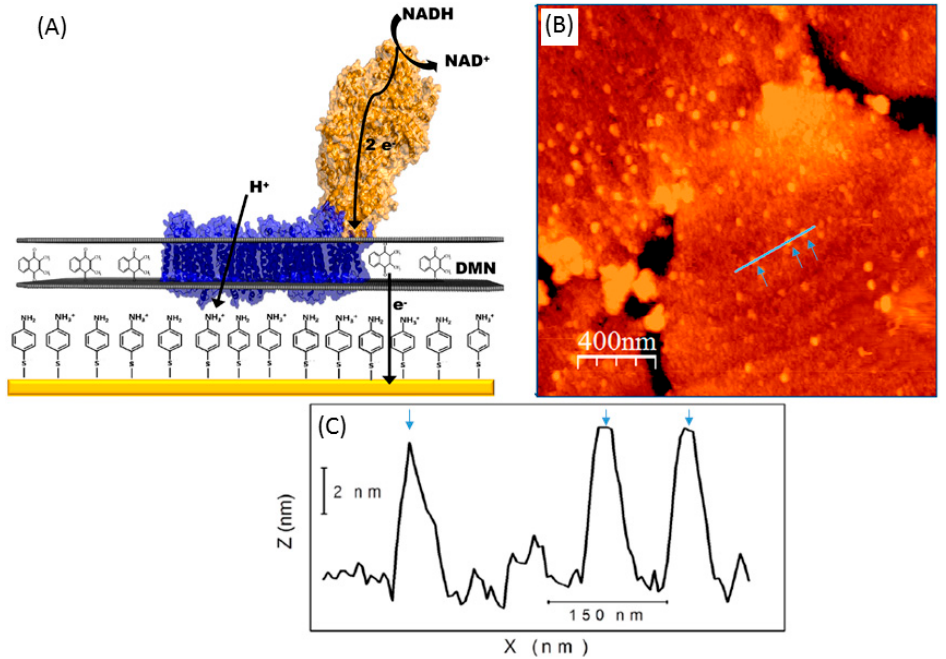
Figure 9. AFM study of the NADH-oxidizing respiratory complex I reconstituted in a phospholipid bilayer on a gold electrode. ( A ) Schematic representation of the reconstitution. The gold electrode is modified with 4-aminothiophenol and the phospholipid bilayer contains the redox mediator 2,3-dimethyl-1,4-naphtoquinone; ( B ) Tapping-mode AFM topography of a gold plate modified with 4-aminothiophenol to which complex I has been immobilized; ( C ) Z-axis profile across the line drawn in ( B ). The arrows indicate features whose height corresponds to the arm of complex I protruding outside the membrane (yellow structure in ( A )). Adapted with permission from [158].